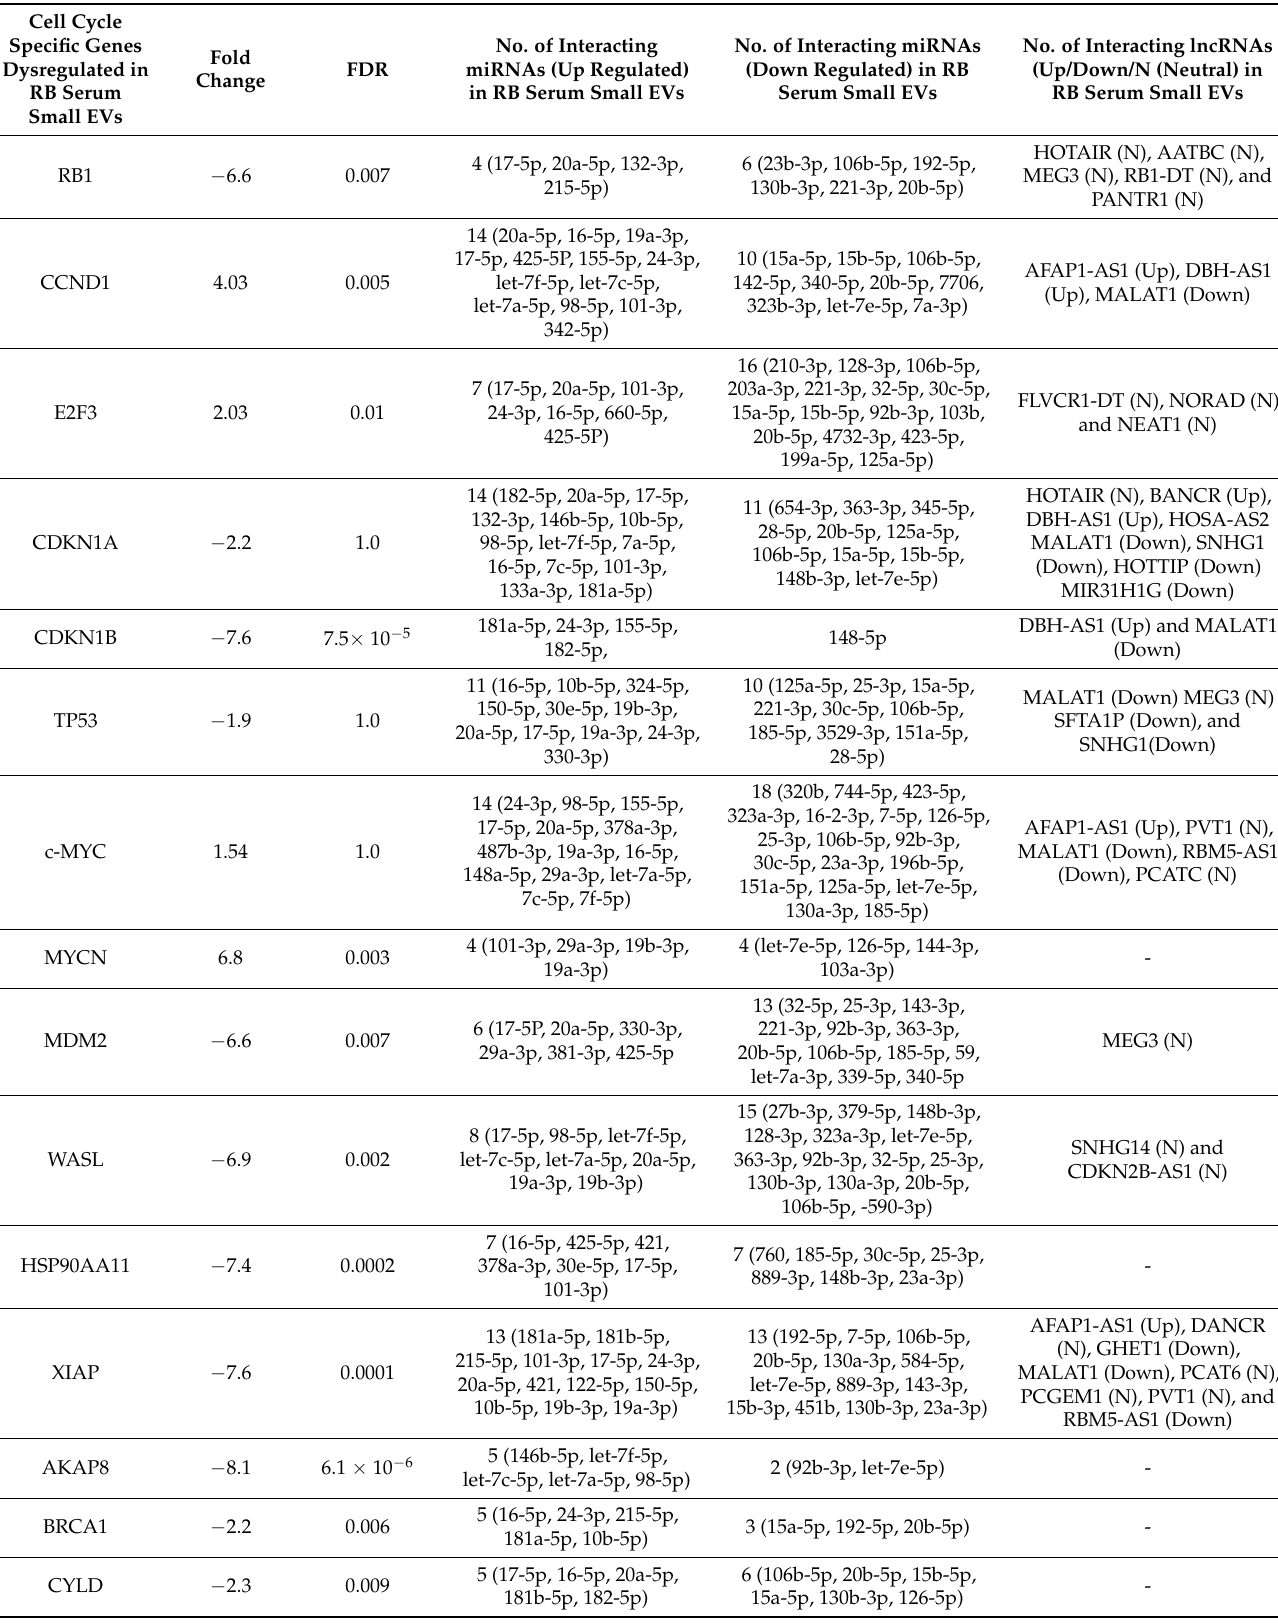
Table 3. Expression status and interactions of miRNAs and lncRNAs with their target dysregulated cell cycle specific genes identified in RB serum small extracellular